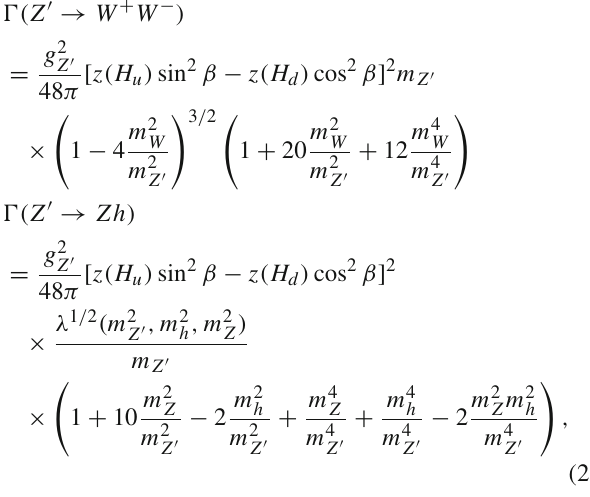
with g Z (cid:2) the U ( 1 ) (cid:2) gauge coupling, N c the number of colours and m f the fermion mass. Notice that the Z (cid:2) boson predom- inantly decays into up-type quarks, given the U ( 1 ) (cid:2) charges in Table 1, where z ( f ) ( − z ( f c )) are the charges for the left (right) chiral fermions. The Z (cid:2) partial width into SM boson pairs